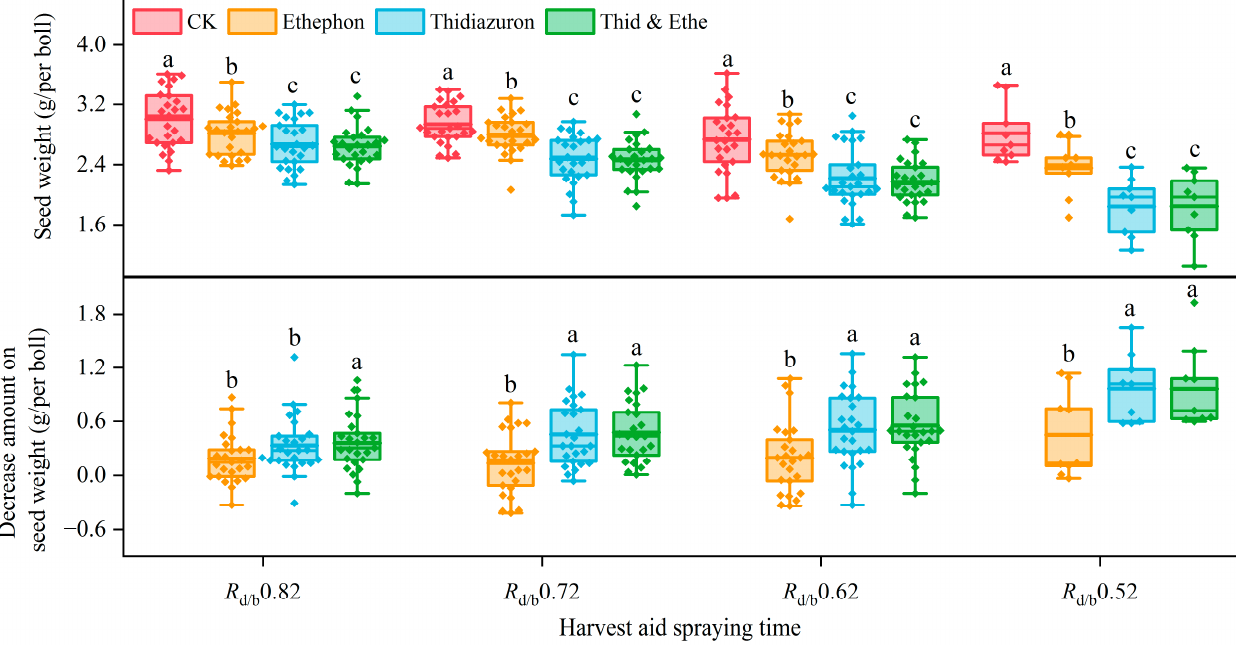
Figure 4. Effects of harvest aid spraying time on seed weight per boll. The thick solid line in the figure indicates the average value. The different letters indicate significant differences between harvest aid treatments at the same spraying time ( p < 0.05). When spraying occurred at R d/b 0.52, the number of samples was 9, and the number of other samples was 25.